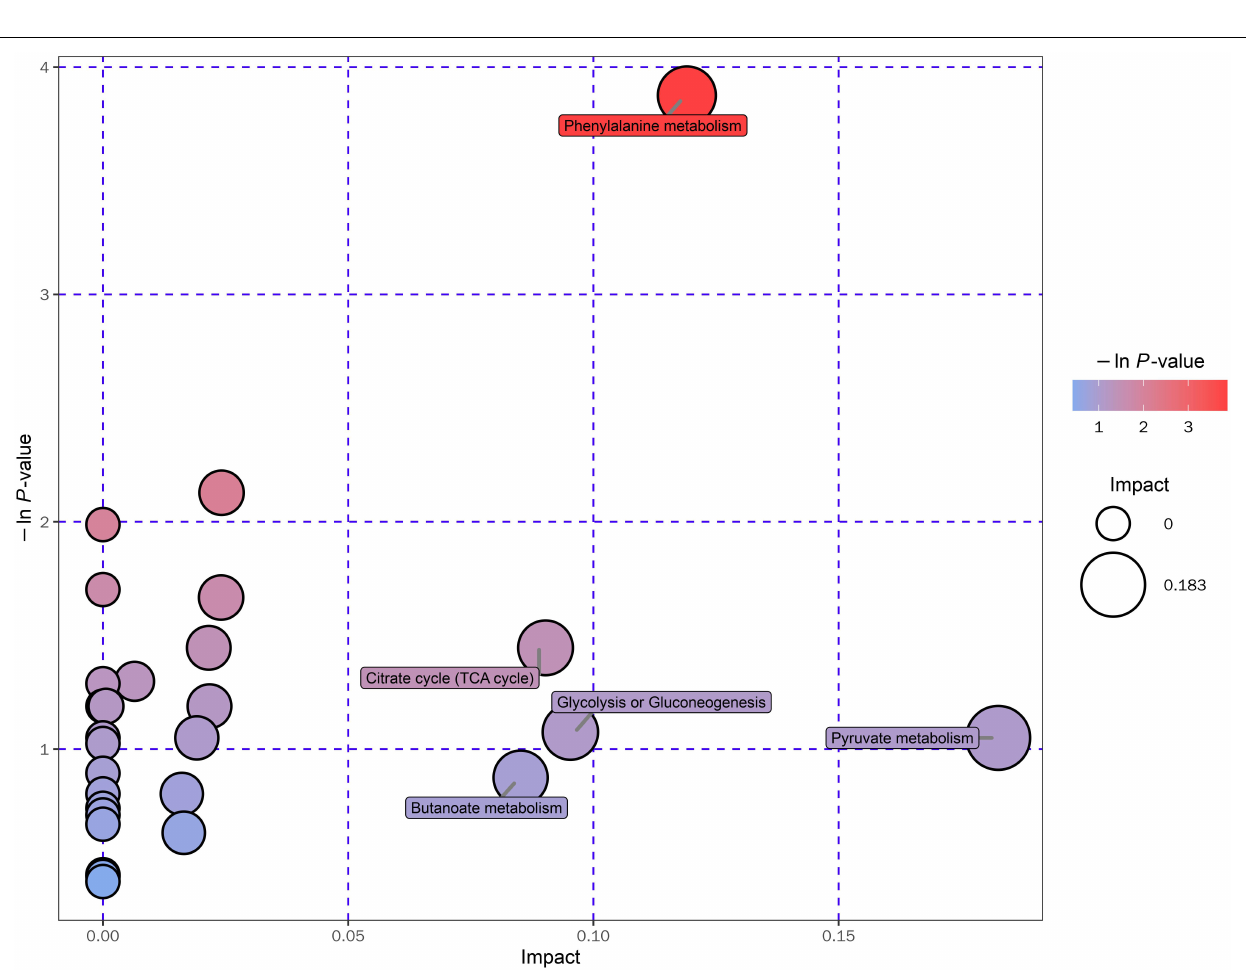
FIGURE 4 | KEGG pathway enrichment analyses of the 12 altered metabolites between the EA group and the non-EA group. Each bubble represented a pathway, and 10 pathways were included in this bubble plot. The bubble size indicated the impact factor of the pathway in the topology analysis, and the bigger the size, the larger the impact factor. The bubble color represented the enrichment degree, and the deeper the color, the smaller the P -value, indicating more significant